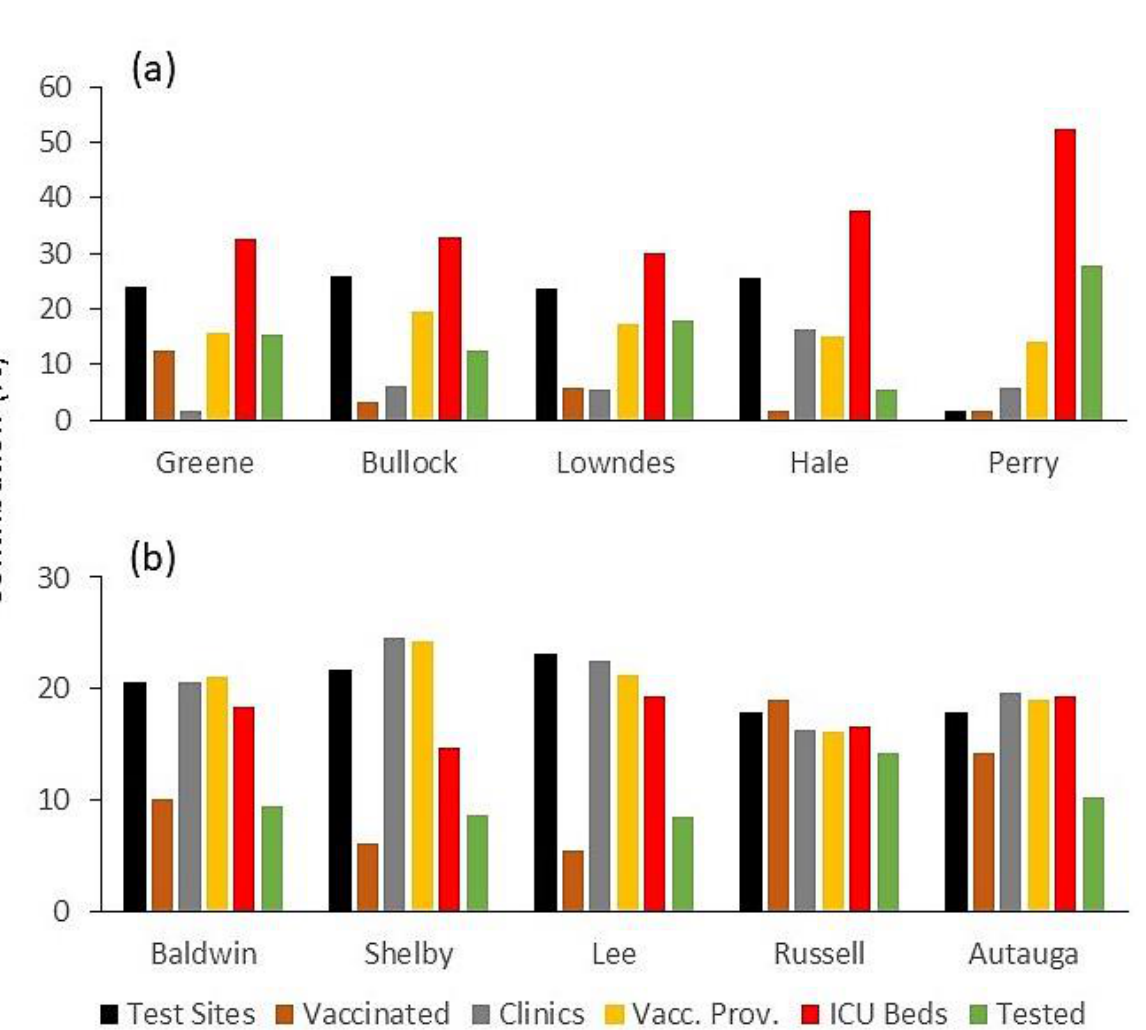
Figure 7. Percent contribution of each indicator to the adaptive capacity subindex for counties with the ( a ) highest and ( b ) lowest subindex scores.